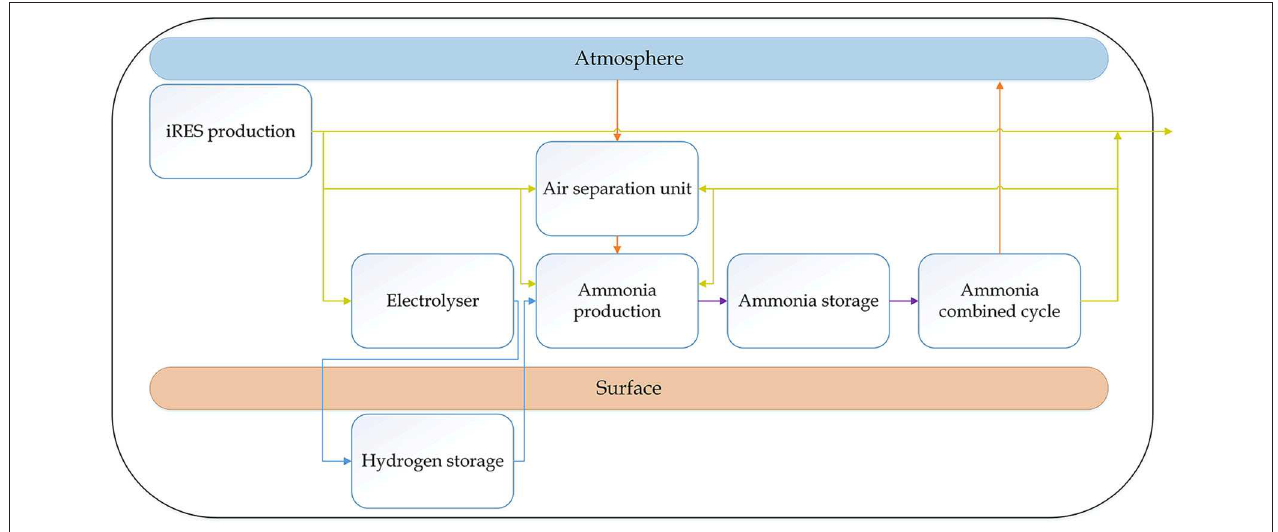
FIGURE 6 | System diagram of the P-A-P system. Yellow lines represent electricity, blue hydrogen, orange nitrogen and purple ammonia.